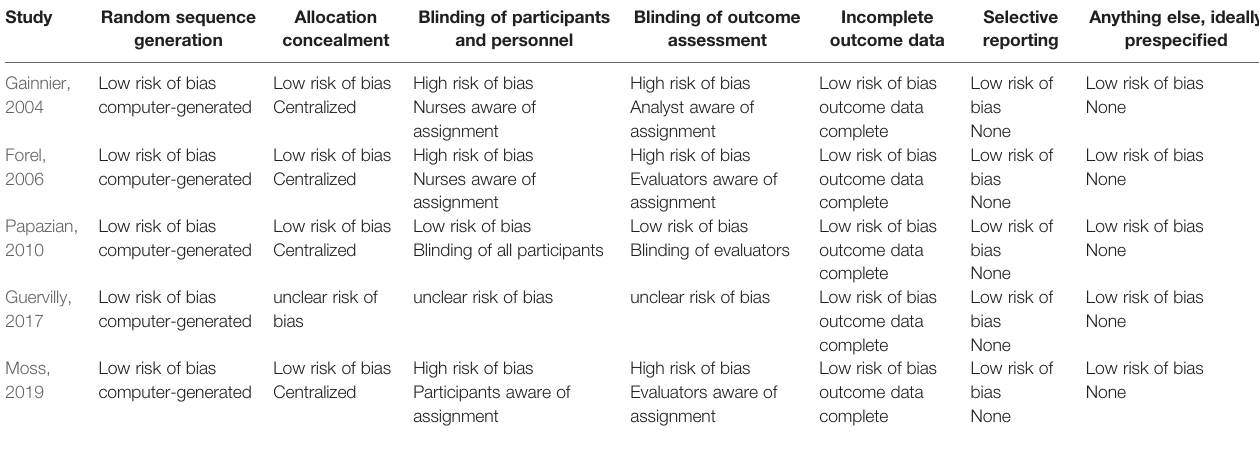
TABLE 3 | Risk of bias